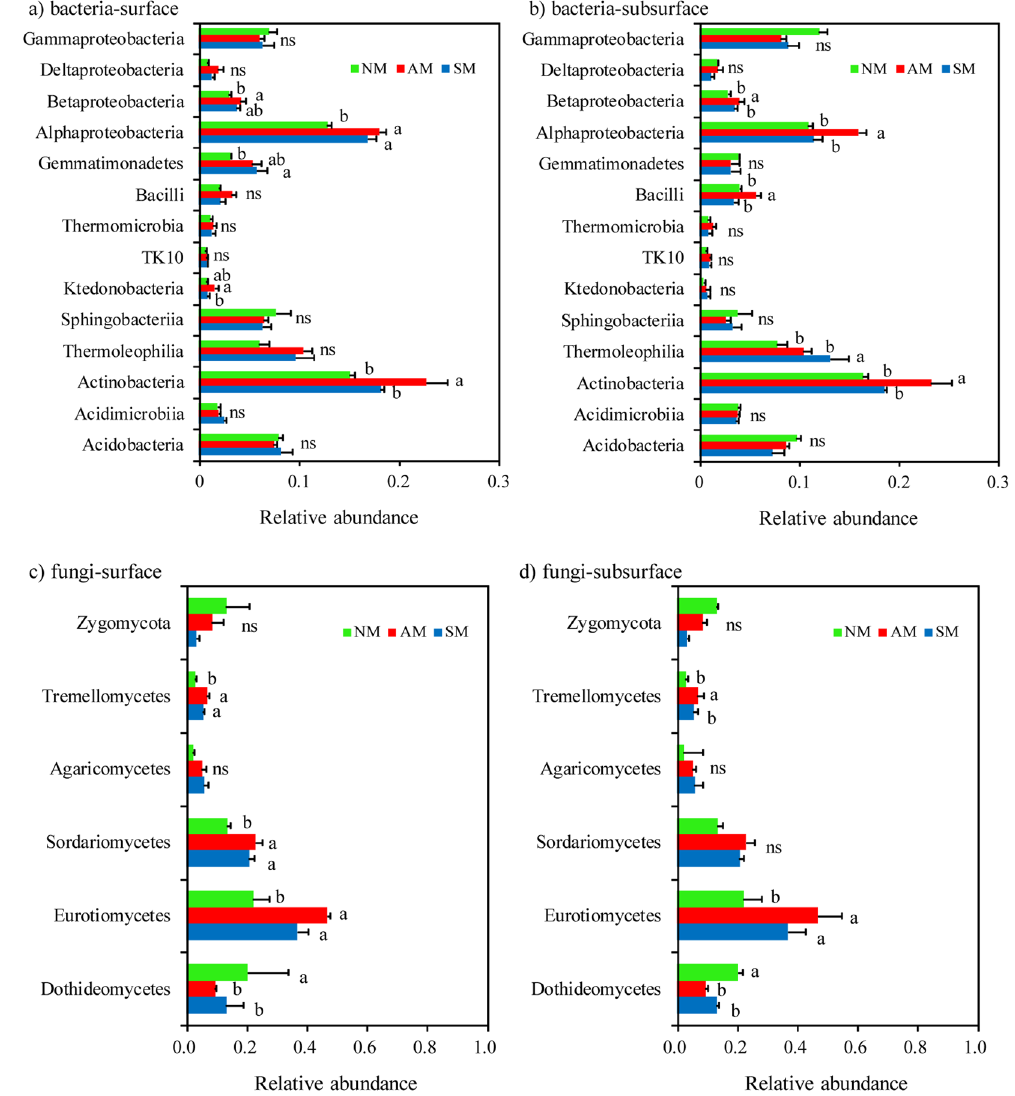
Figure 3. Taxonomic distributions of predominant classes of bacteria ( a , b ) and of fungal classes in surface ( c ), and, subsurface ( d ) soil samples. The different letter indicates significant difference at P <